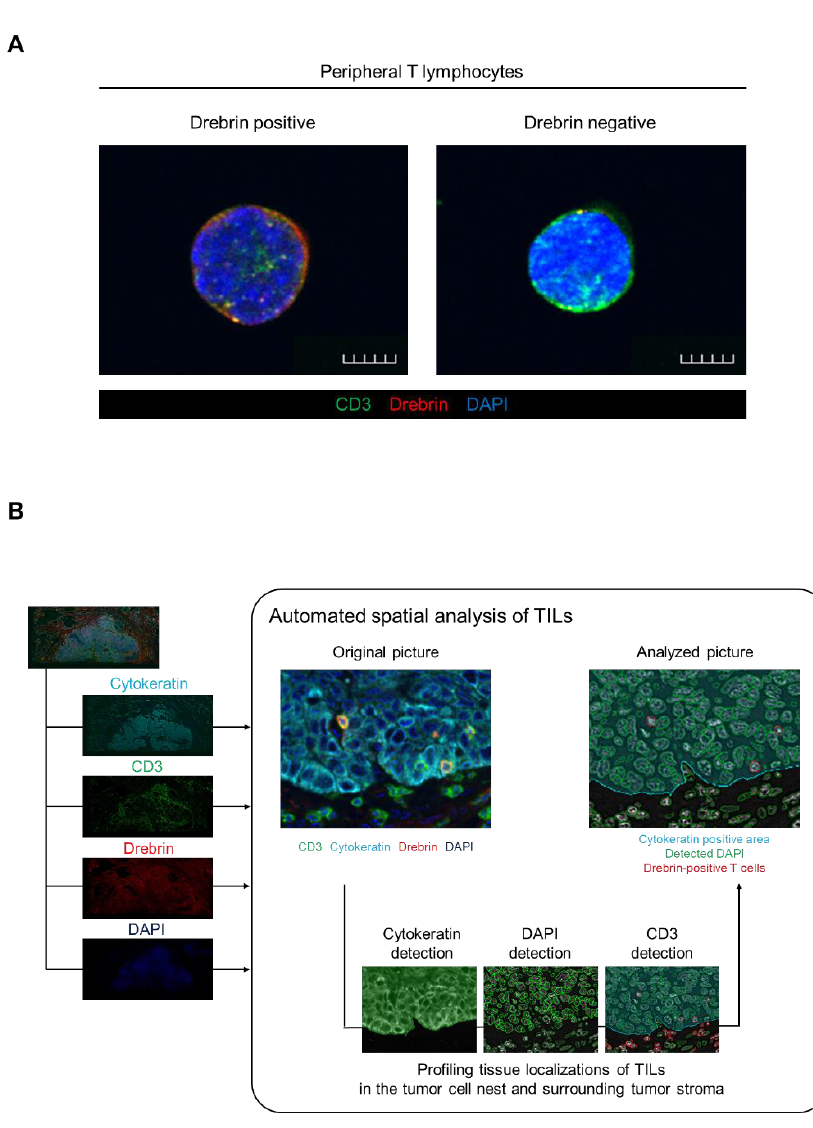
Figure 1. Drebrin expression detected in peripheral T cells and schematics of TIL analysis among patients with primary squamous cell cancer. ( A ) Representative images of the peripheral T cells. Purified T cells from healthy donors’ peripheral blood were stained with CD3 (green), drebrin (red), and DAPI (blue). Scale bars, 50 µm. ( B ) Schematics of the automated spatial analysis of the TILs. Surgical tissue specimens from patients with squamous cell lung cancer (N = 34) were stained by multiplex fluorescent immunohistochemistry, and images of all the tumor areas were analyzed. TIL, tumor-infiltrating lymphocyte.